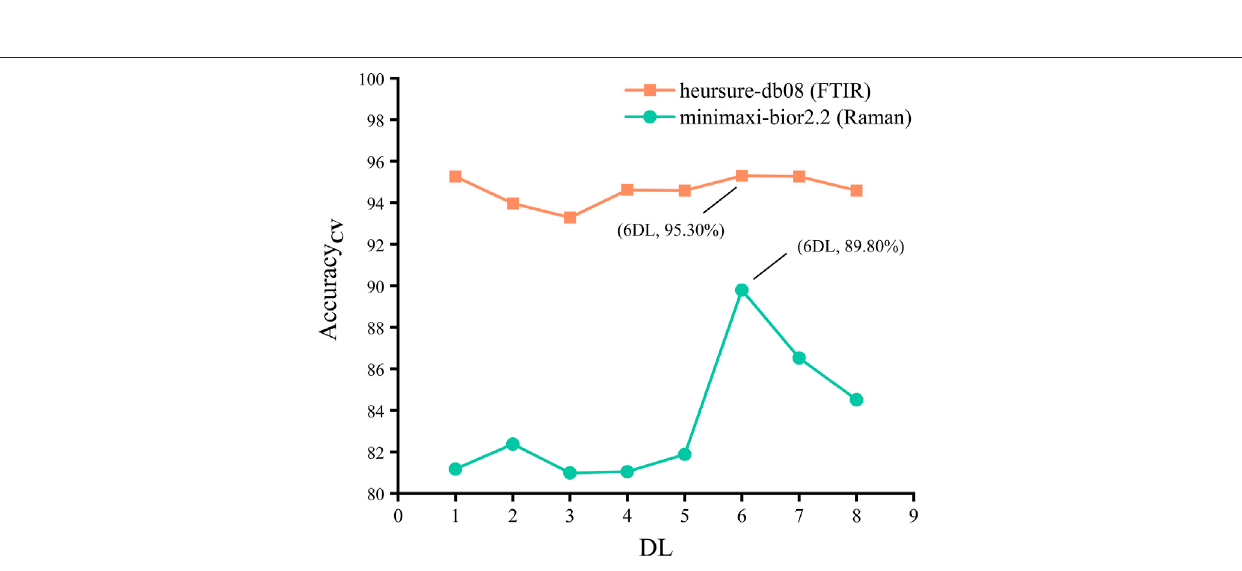
non-subsampled rotated complex wavelet transform (NSRCxWT) extraction image fusion algorithm based on computed tomography (CT) and MRI features and found that